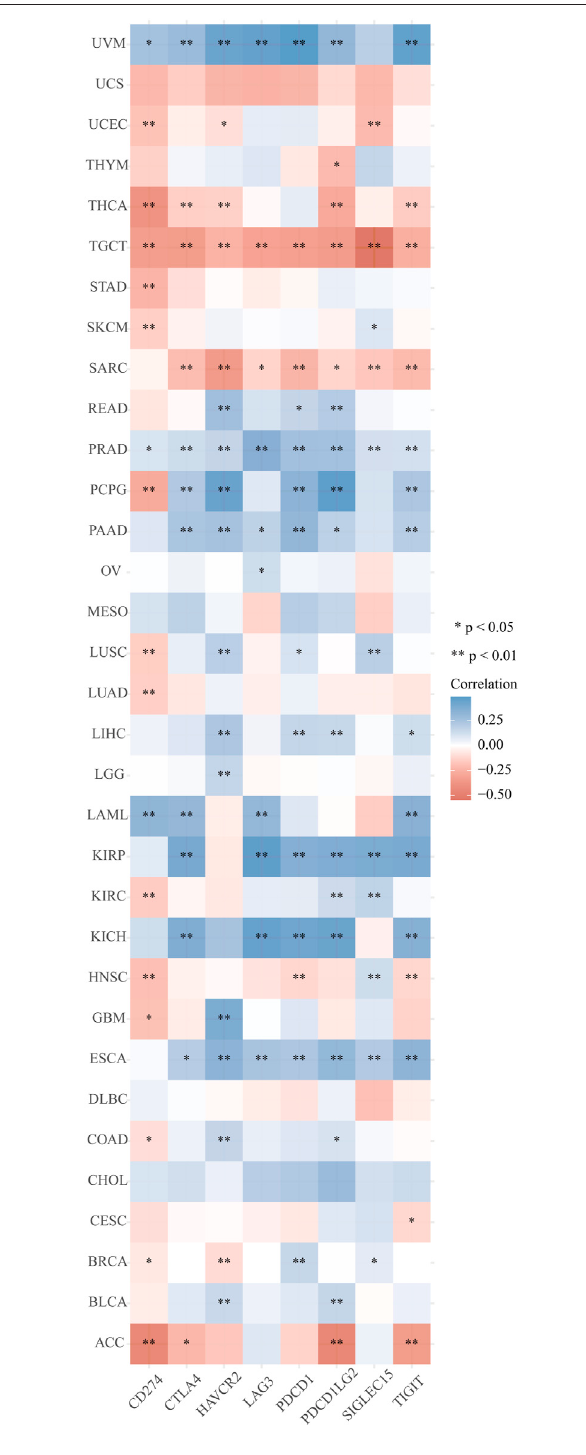
FIGURE 12 | Correlation analyses of the PPP1R14A expression with immune checkpoint genes in pan-cancer.